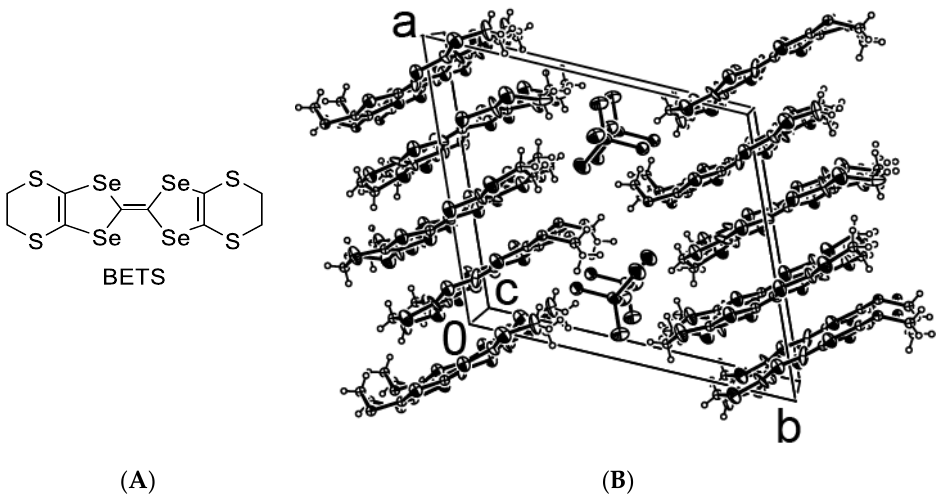
Figure 3. ( a ) The chemical structure of the BETS (BETS = (bis(ethylenedithio)-tetraselenafulvalene)) molecule; ( b ) A typical crystal structure of the magnetic superconductors: λ -(BETS) 2 FeCl 4 . Note that one of the ethylene groups at the end of BETS is bent toward FeCl 4 − to favor the π – d interaction. Reproduced from Ref. [511] with permission.